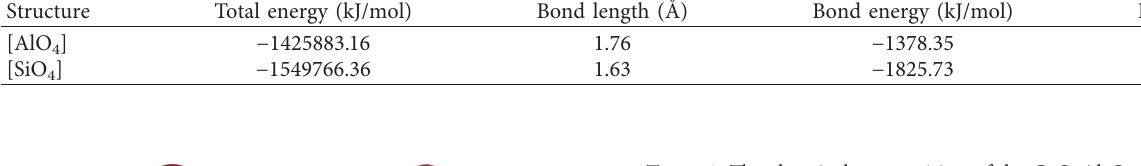
2 O 3 -based mold